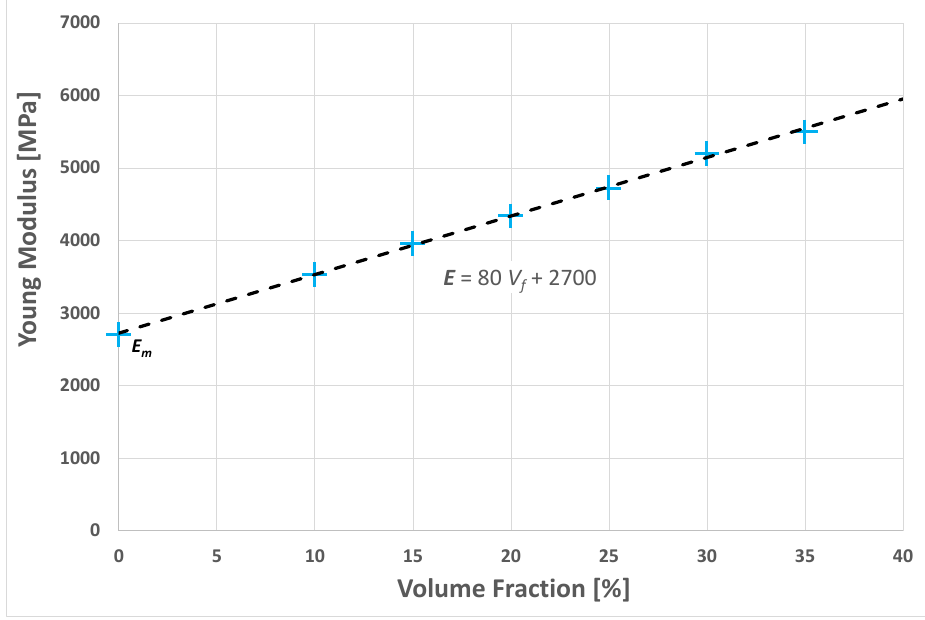
Figure 7. Graph of the Young’s modulus of the biocomposite vs. the fiber volume fraction V f .